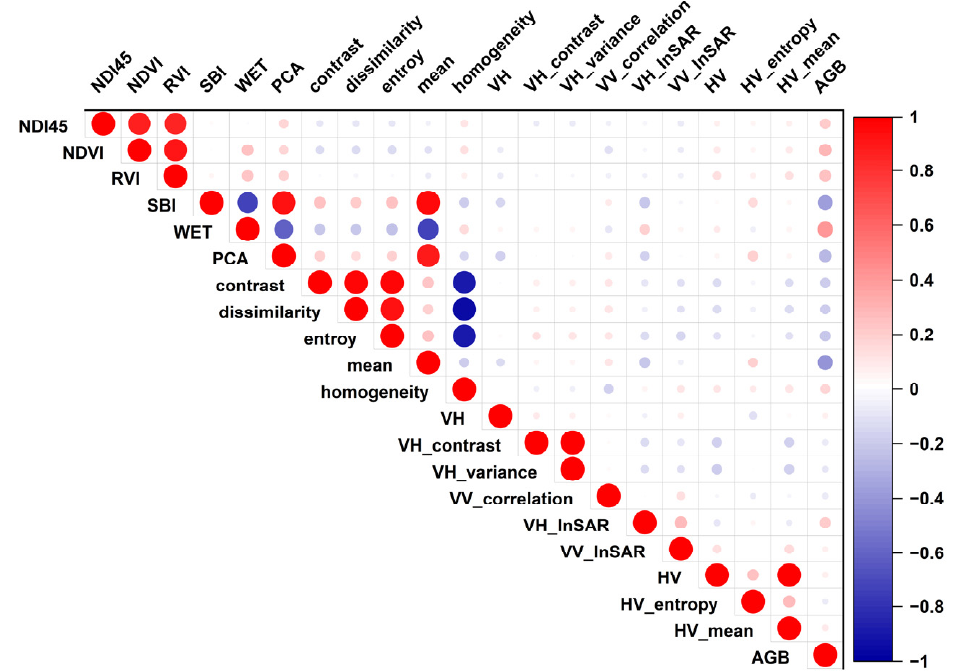
Figure 3. The importance of predictor variables, 20 variables with a high Pearson correlation coeffi- cient were selected to observe the correlation among variables.